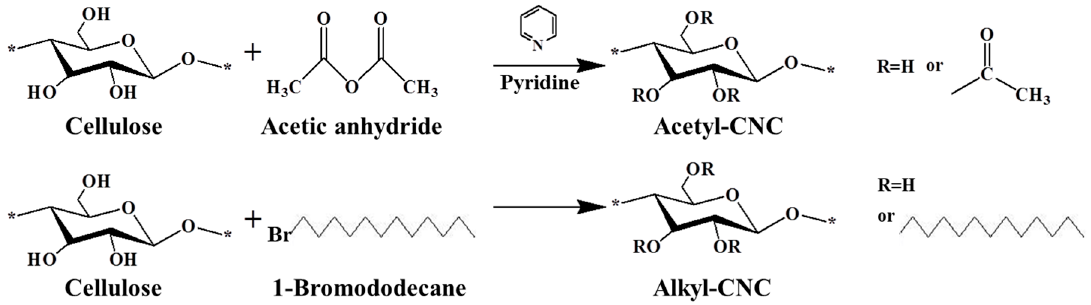
Figure 1. Synthetic procedure for surface modification of CNC.